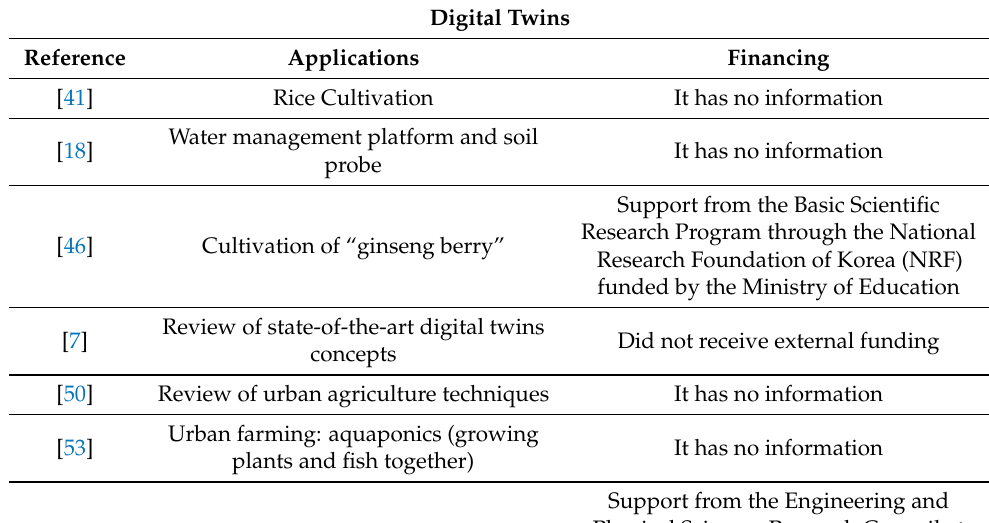
Table 15. All digital twins and their respective